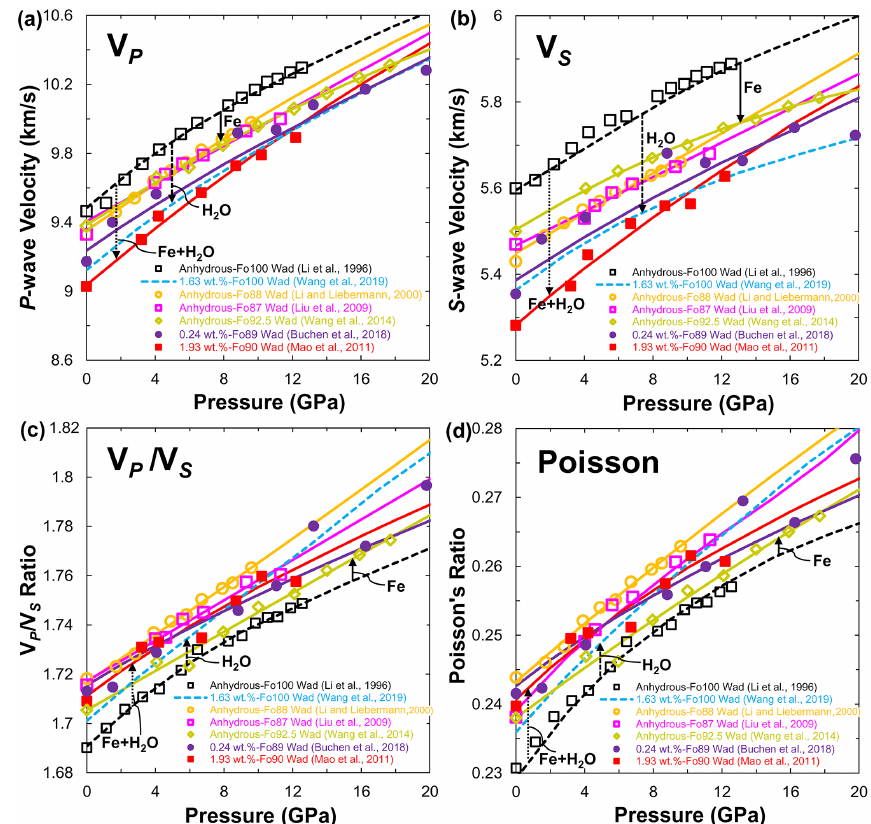
Figure 11. (a) Compressional ( V P ), (b) shear wave ( V S ) velocities, (c) V P /V S ratio and (d) Poisson’s ratio of wadsleyite at 300K as a function of pressure. Data sources: anhydrous wadsleyite (single crystal: Wang et al., 2014; polycrystal: Li et al., 1996; Li and Liebermann, 2000; Liu et al., 2009); hydrous wadsleyite single crystal (Mao et al., 2011; Buchen et al., 2018; Wang et al., 2019). Closed and open symbols denote the experimental data, and solid and dashed lines stand for the calculated results from third-order finite strain